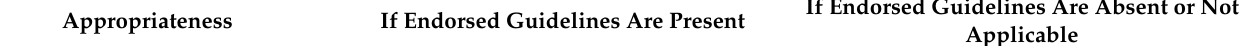
Table A1. National Antimicrobial Prescribing Survey (NAPS) tool for assessment of antibiotic appropriateness/[17].